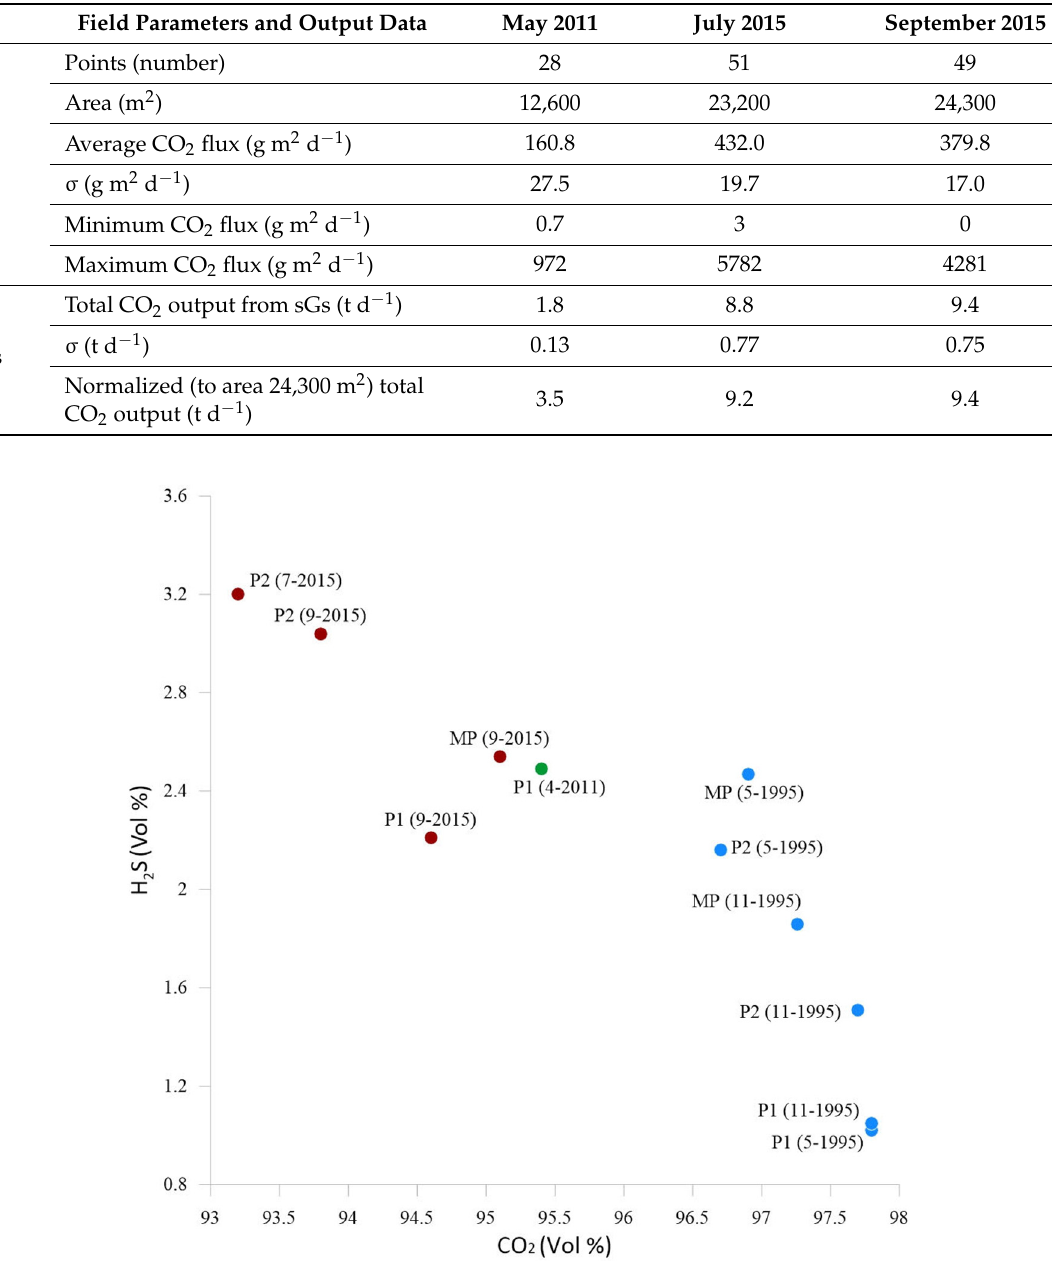
Figure 6. H 2 S vs. CO 2 contents in the fluids of the Baia di Levante area, measured from 1990 to